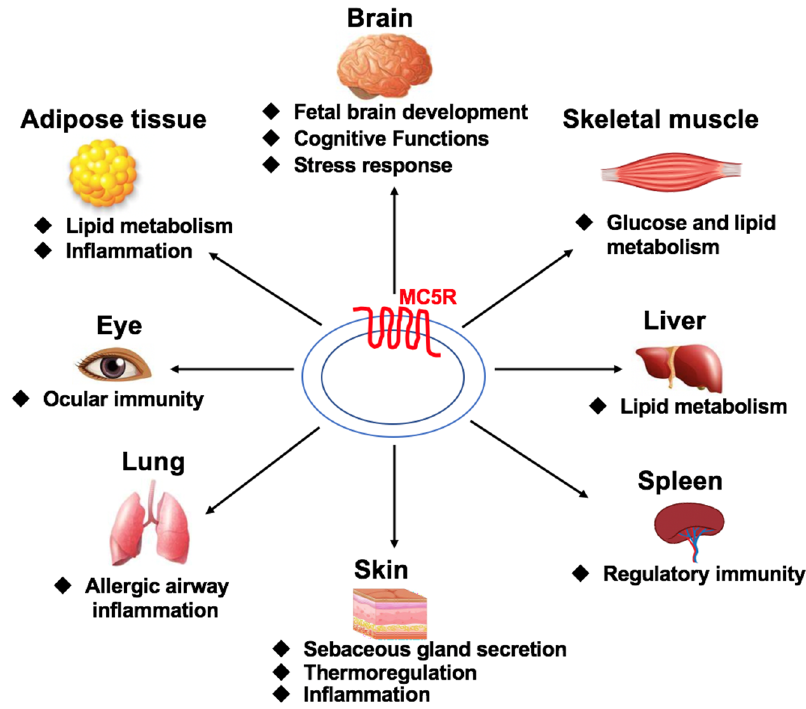
Figure 1. Multiple functions of MC5R in various tissues.